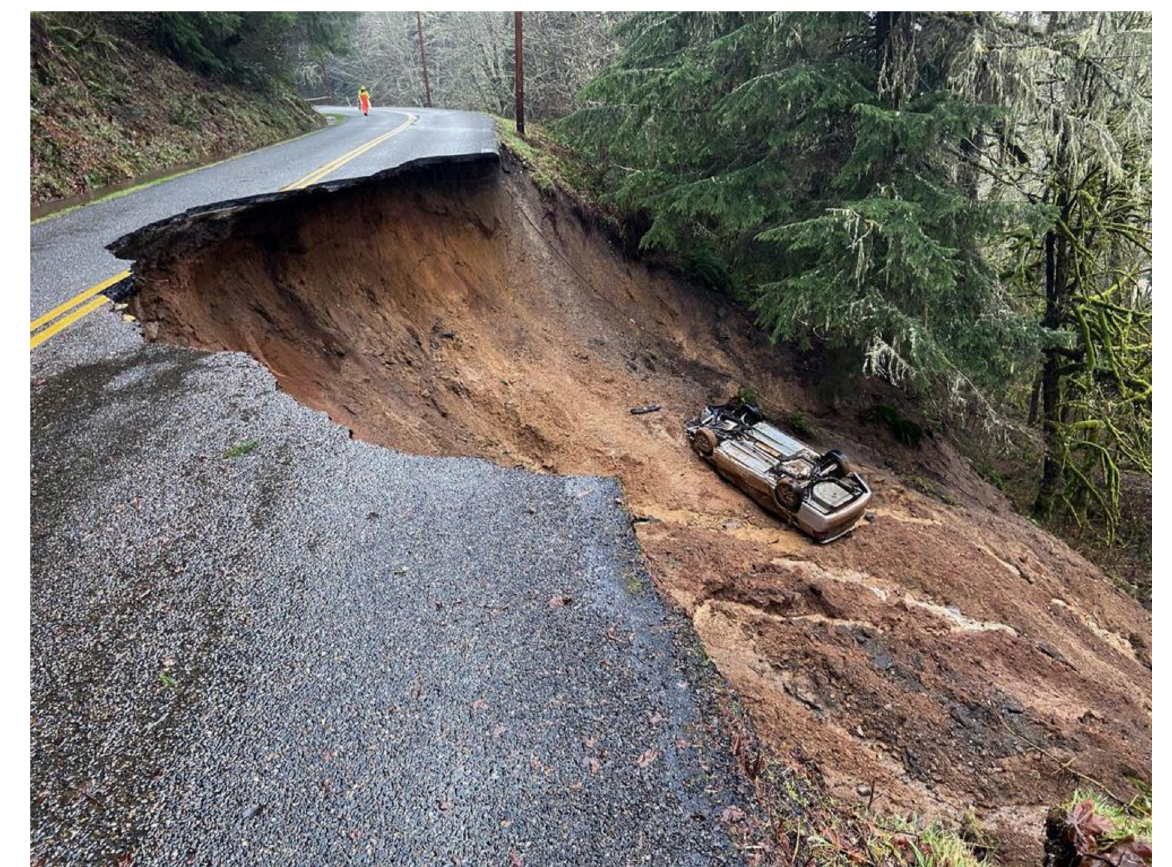
Figure 1. Landslide in Washington—18 February 2020